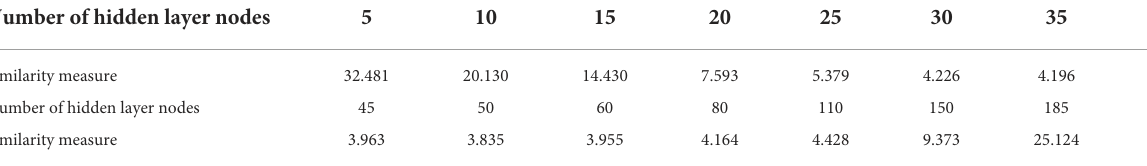
TABLE 3 Calculation results of S ( L ) (unit: 10 3 ).